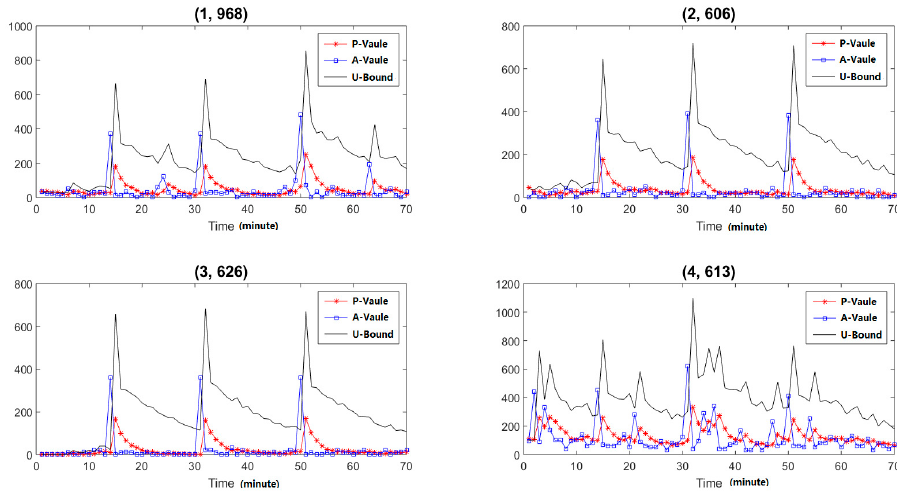
Figure 9. Changing trends of abnormal items.